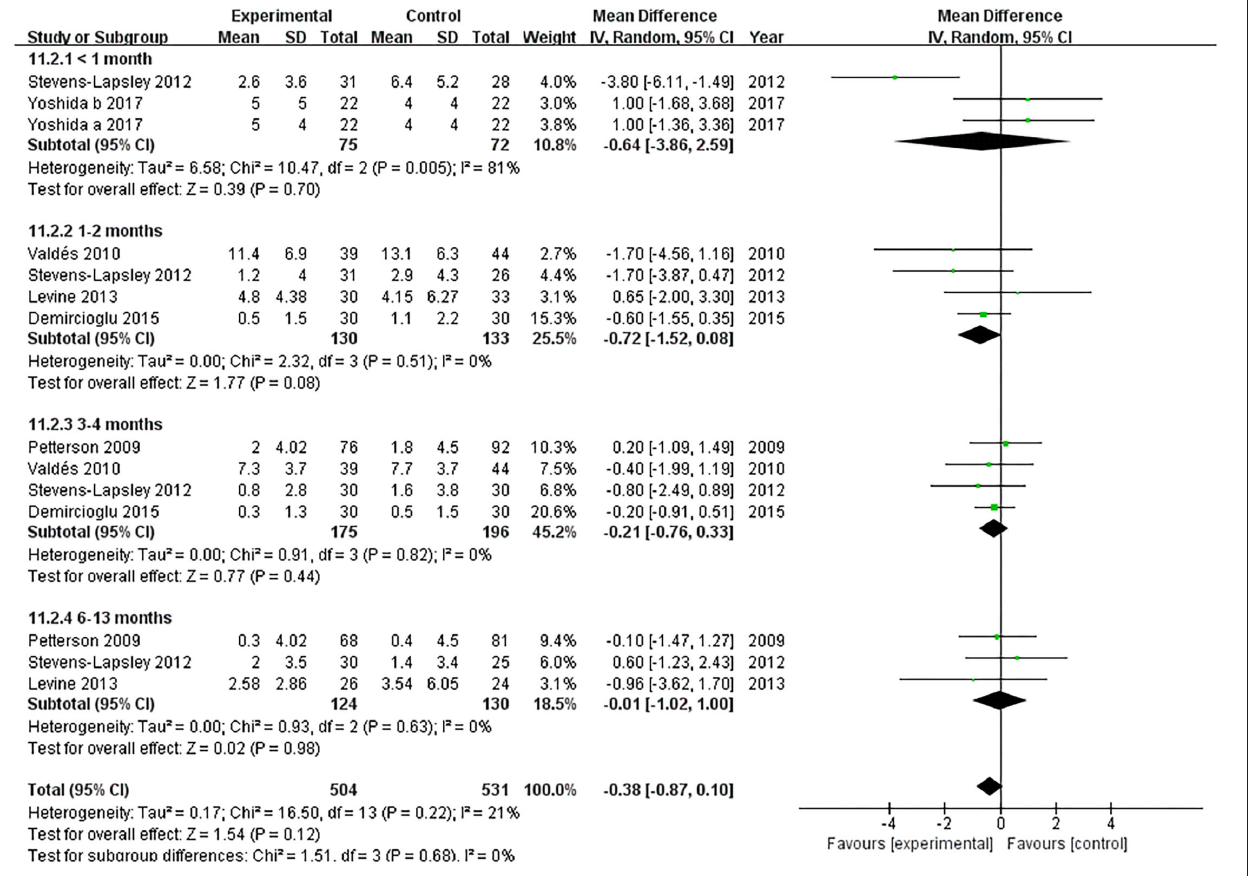
detected ( I 2 = 0%). The forest plot of SF-36 MCS was shown in Figure 15